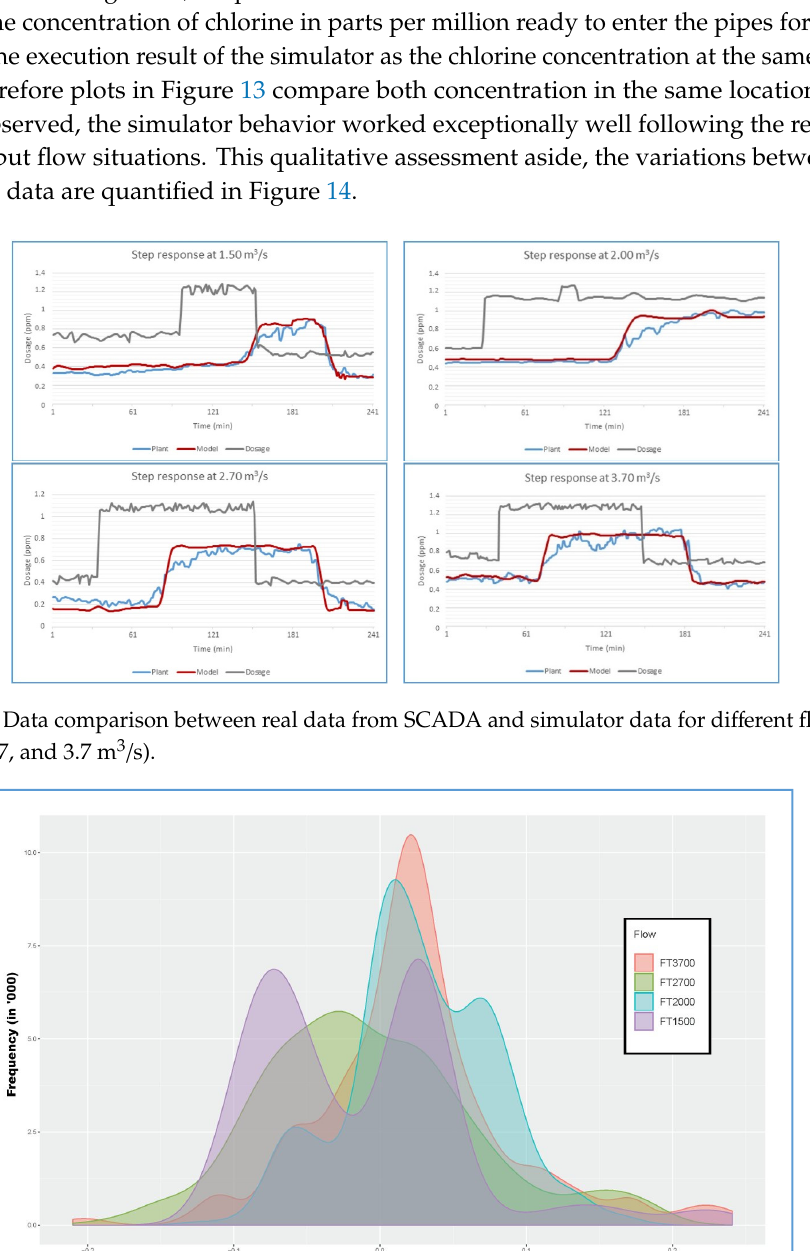
Figure 14. Plot of residuals for different flow rate operating points (1.5, 2.0, 2.7, and 3.7 m 3 /s).